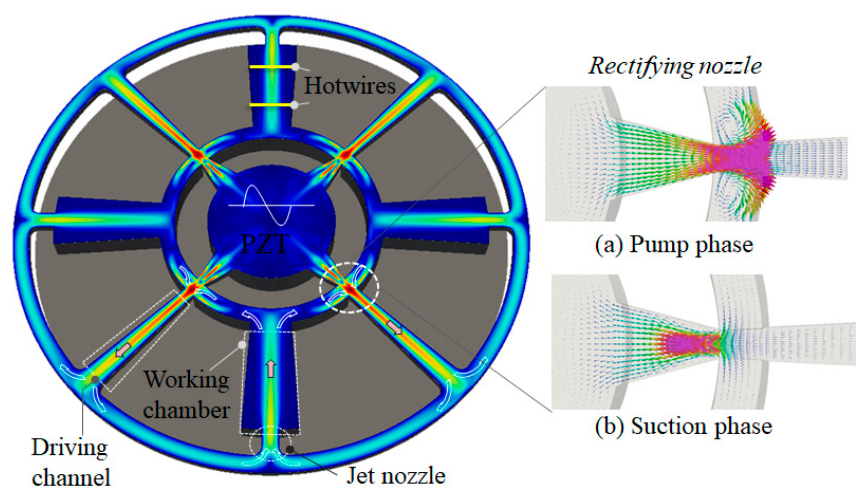
Figure 2. Time-averaged flow fields inside the device (red: highest velocity). The arrows indicate flow direction. ( a ) The insets show instantaneous flow in the pump phase where most of the flow goes straight out of the pump chamber entering the driving channel. ( b ) In the suction phase, the drawn back flow is mostly from the spaces perpendicular to the driving channel.